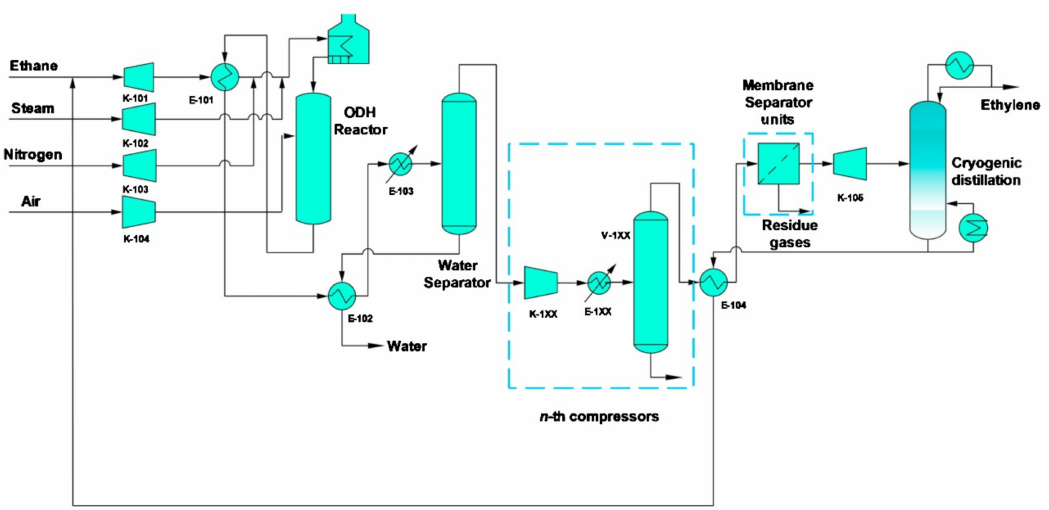
Figure 24. Overall generalized process flow diagram of the ODH process. Adapted from ref. [137], Copyright (2017), with permission from Elsevier.